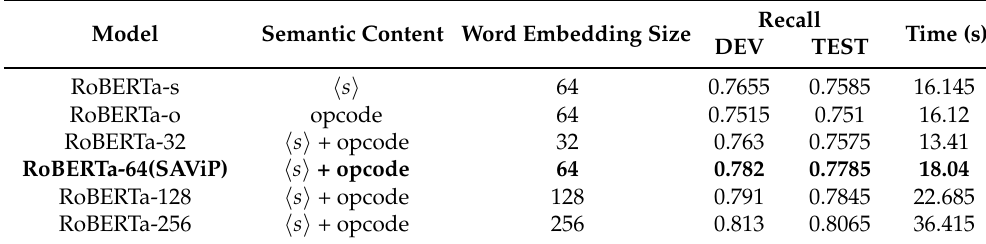
Table 6. Language model experiments.